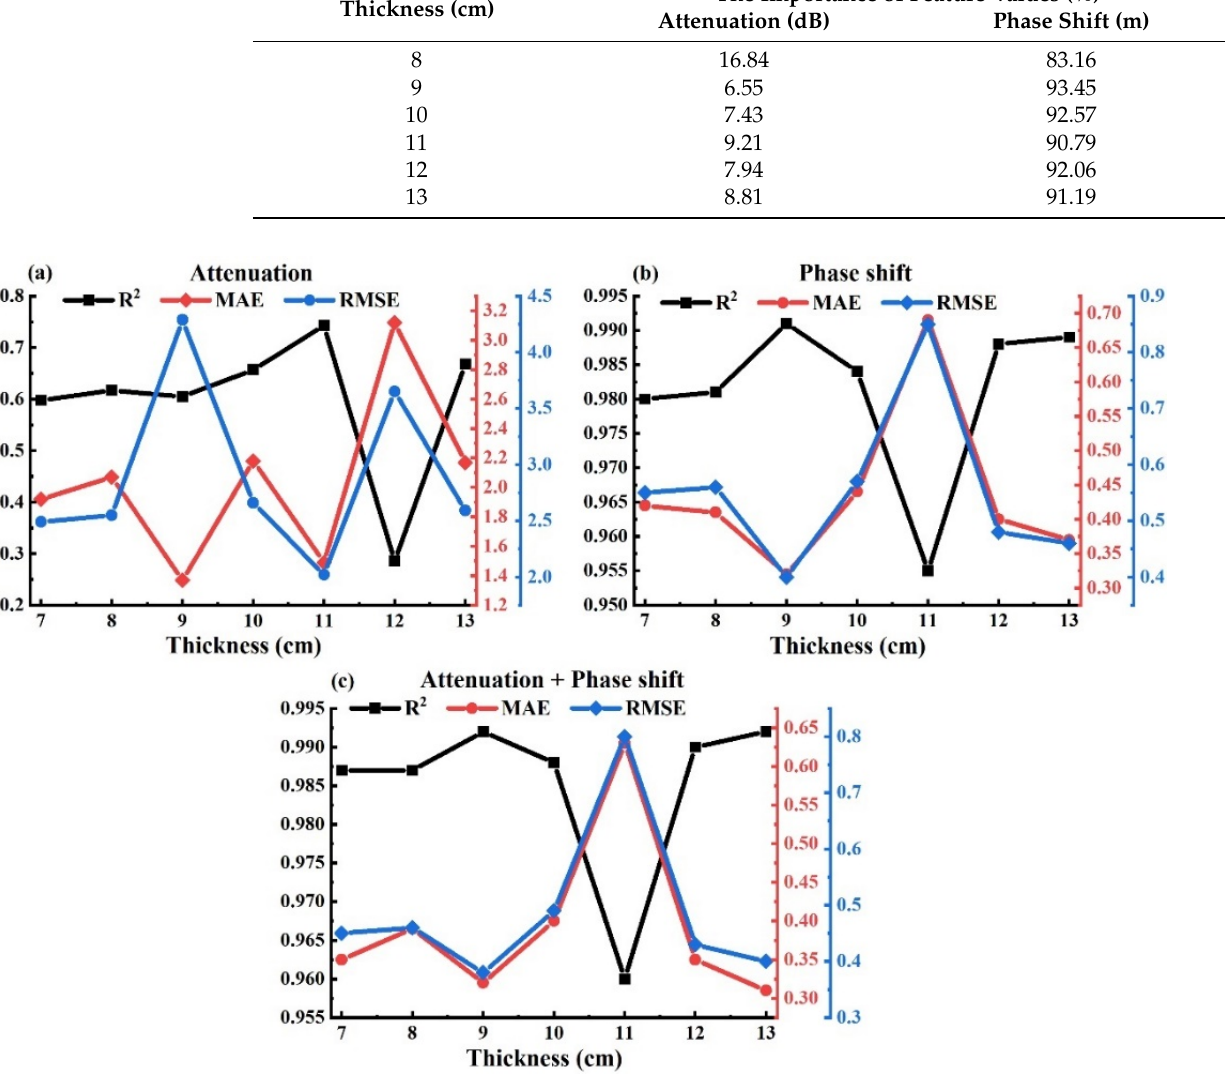
Figure 9. Feature importance verification: ( a ) the results based on attenuation; ( b ) the results based on phase shift; ( c ) the results based on attenuation and phase shift. on phase shift; ( c ) the results based on attenuation and phase